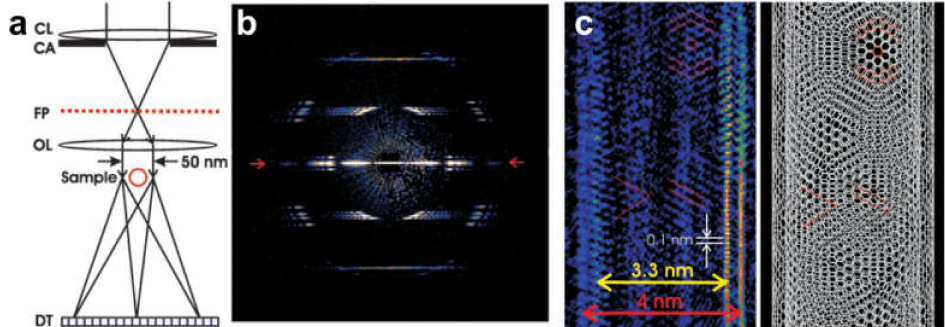
Figure 25. Coherent diffraction imaging of double-walled carbon nanotubes (DWCNTs) with